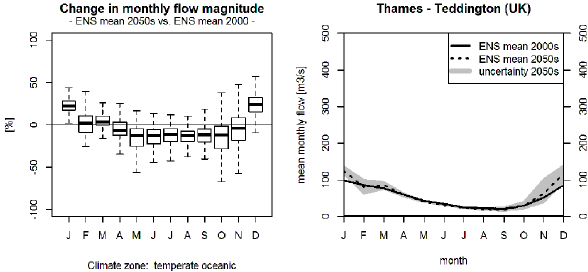
Fig. 12. Direction of change in the 2050s plotted for all grid cells of the temperate oceanic climate zone (left) and the Thames river near Teddington